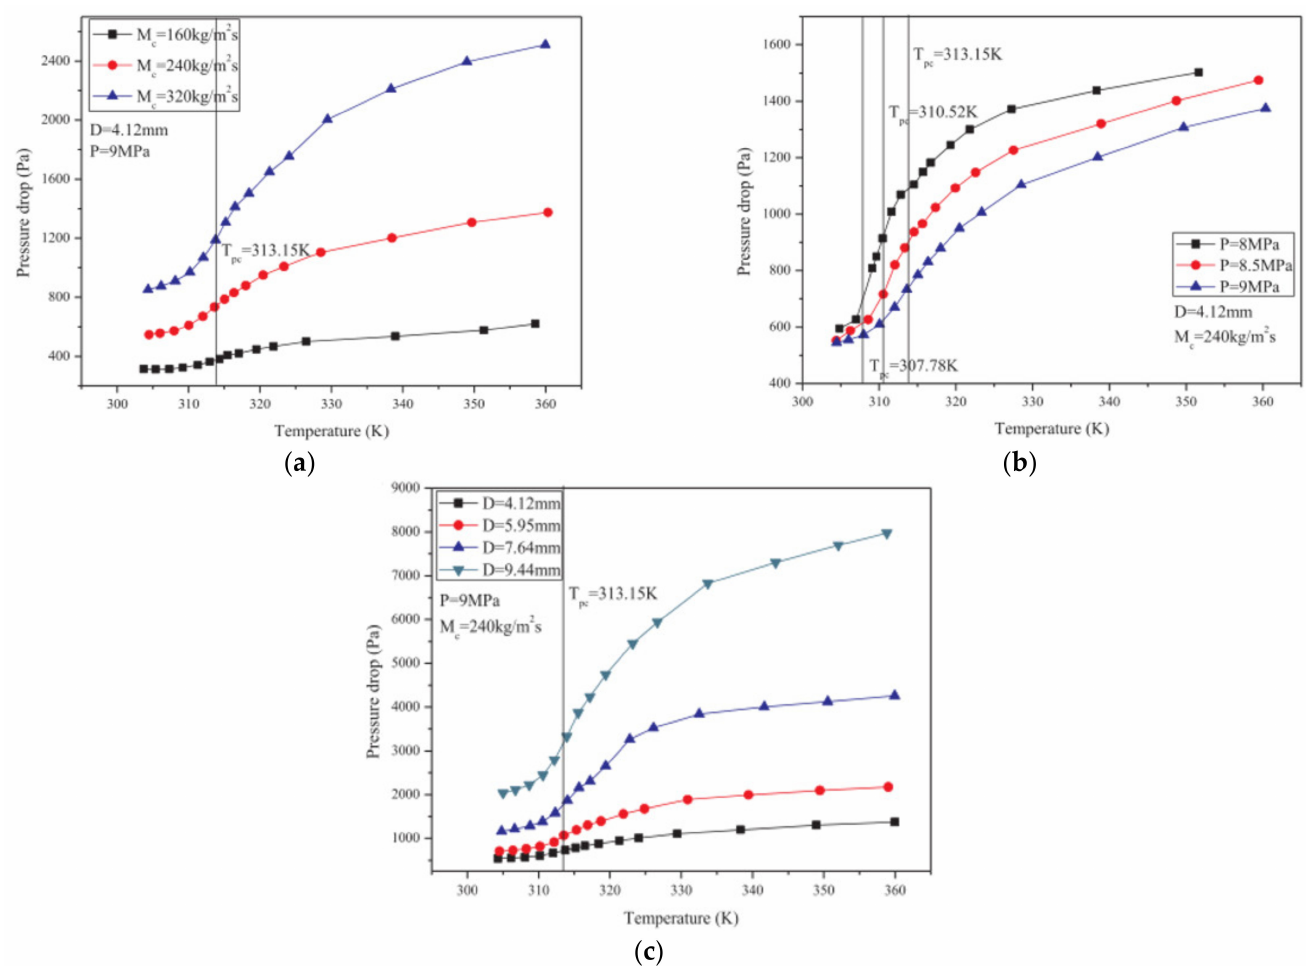
Figure 8. Pressure drop at different mass fluxes ( a ), pressures ( b ), and tube diameters ( c )